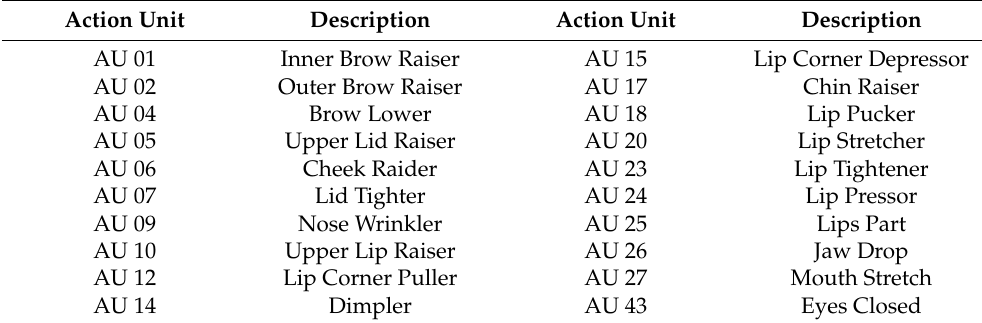
Table 2. Description of Action Units.